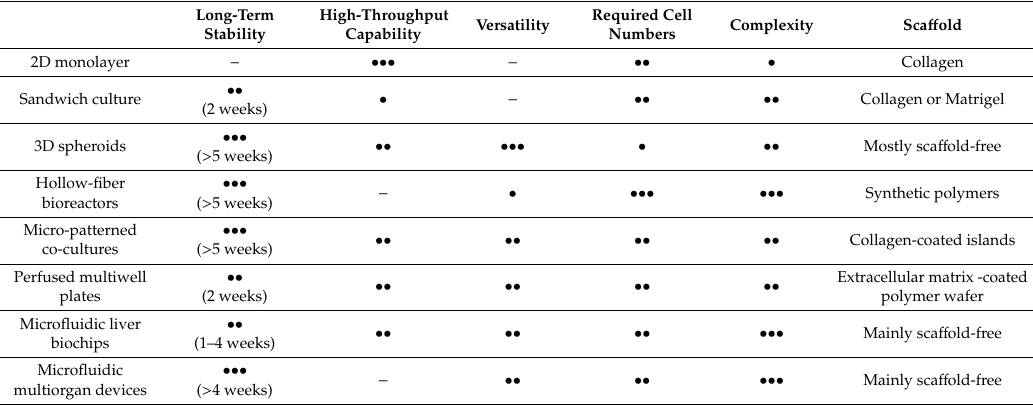
Table 1. Comparison of hepatocyte culture methods.